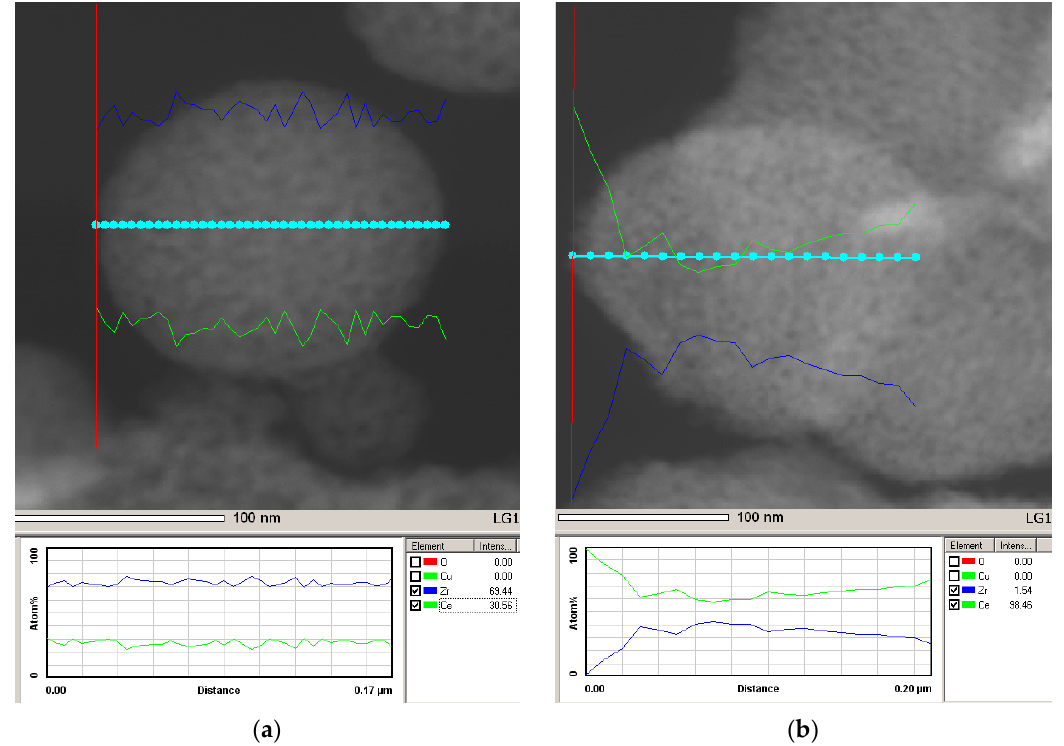
Figure 5. STEM-EDX images for Ce x Zr 1-x supports: a—Ce 0.3 Zr 0.7 , b—Ce 0.7 Zr 0.3 .